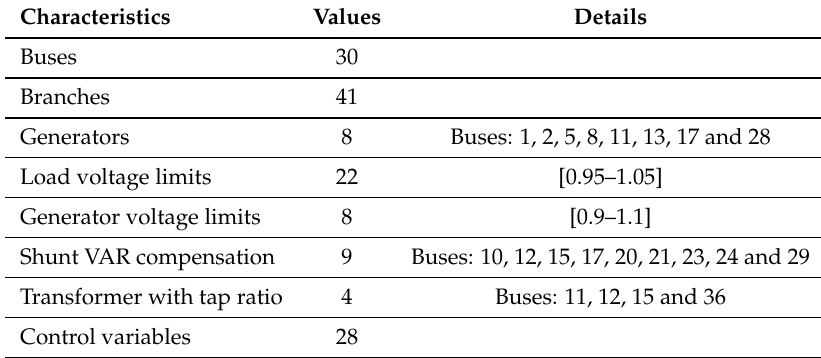
Figure A2. Scenario 3: IEEE 30-bus Modified (2). Table A6. The general specifications of the IEEE 30-bus modified